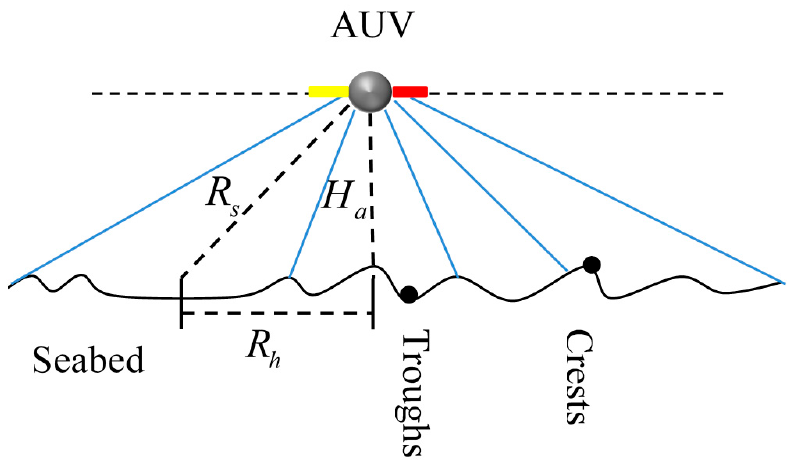
Figure 1. SSS characterization in sand wave inspections. The spatial relationship between the operating range and AUV height is,